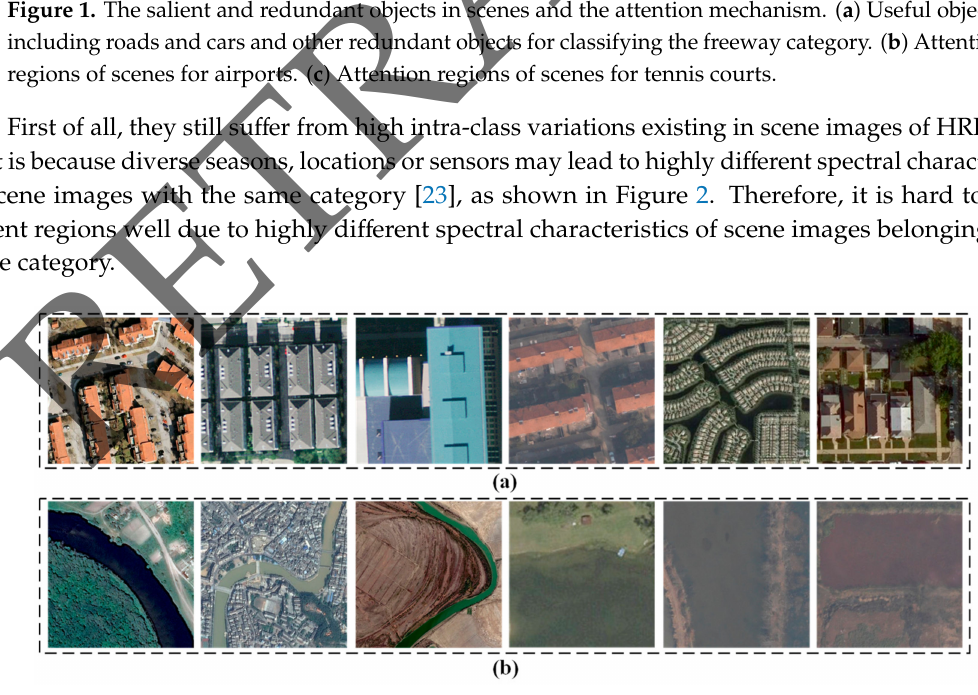
Figure 2. The intra-class diversity of remote sensing scene images. ( a ) Residential scene images. ( b ) River scene